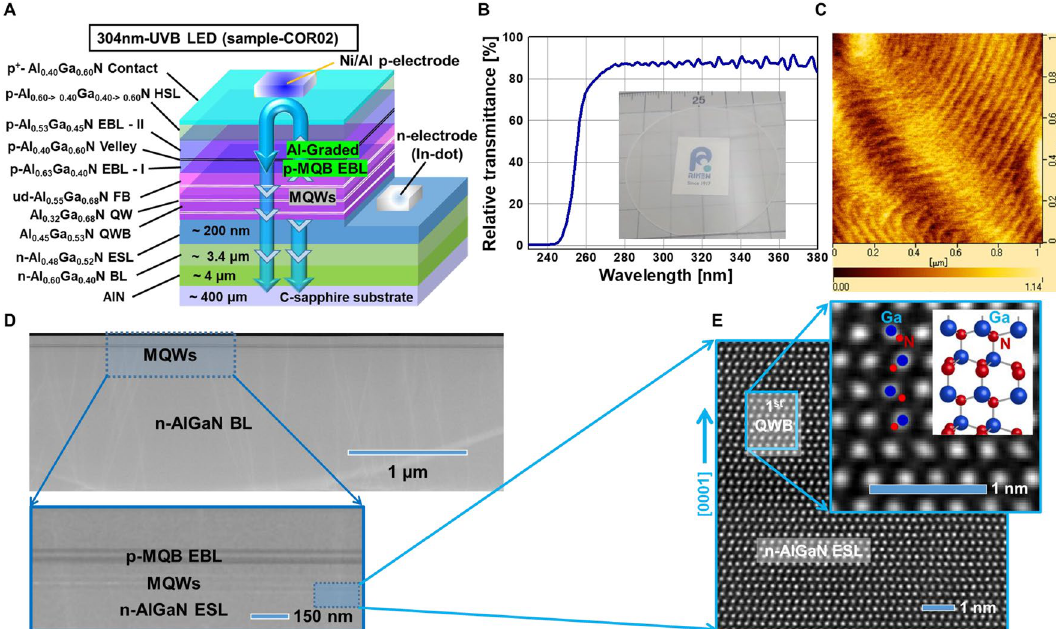
Figure 3. ( a ) Schematic diagram of state-of-the-art 304 nm-band AlGaN-based ultraviolet-B (UVB) light- emitting diode (LED) (sample-COR02), ( b ) Optical characterisation of the whole UVB LED (p-AlGaN-based UVB LED crystal wafer is shown in the inset), ( c ) AFM image of the final p-AlGaN contact-layer of UVB LED (sample-COR02), ( d ) HAADF-STEM image of sample-COR02, and ( e ) Magnified HAADF-STEM image of sample-COR02 taken around the n-AlGaN electron source layer (ESL) and MQWs (active region) to confirm the crystal quality at atomic resolution